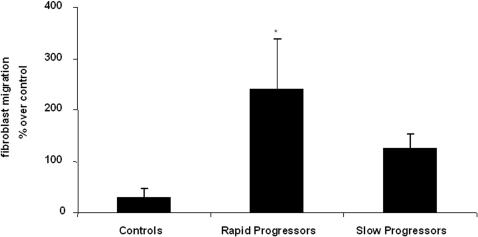
Fibroblast migration.Fibroblasts were placed in the upper compartment of a Boyden-type chamber, and F-12 medium containing 5% BSA alone or with 50% BAL fluid was added to the lower compartment. After 8 h of incubation, the migrating cells were stained and the absorbance of the stained solution was measured by ELISA. *p<0.01 versus controls and p<0.05 versus slow progressors.